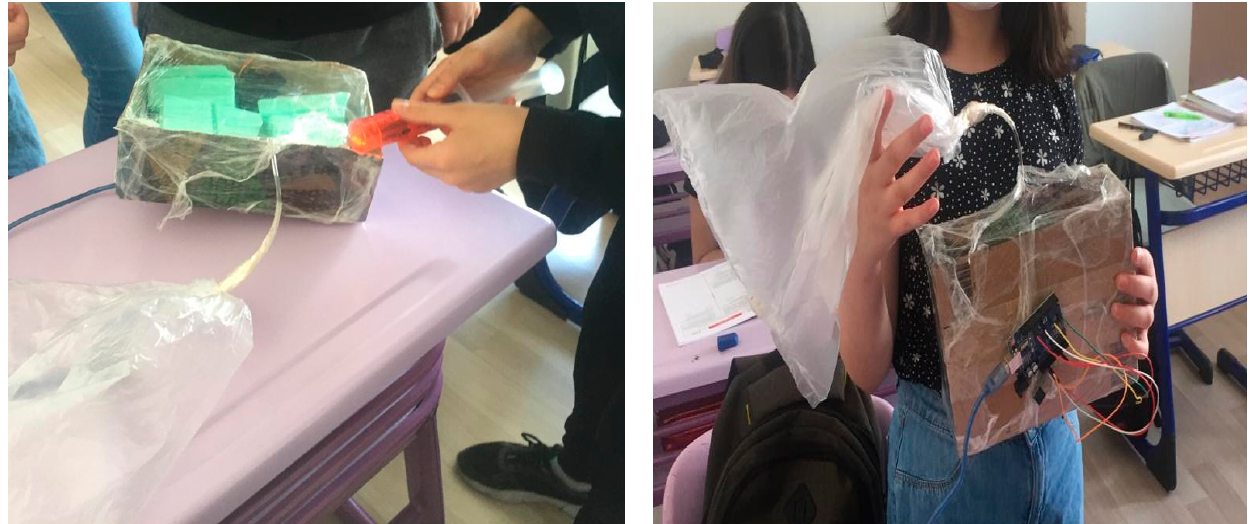
Figure 3. Pulmonary Circulation with a waterflow sensor. The plastic bag represents the lung and the box represents the heart.